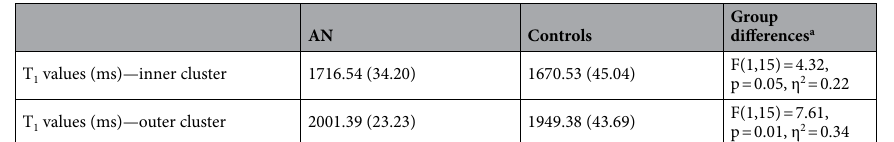
Group differences